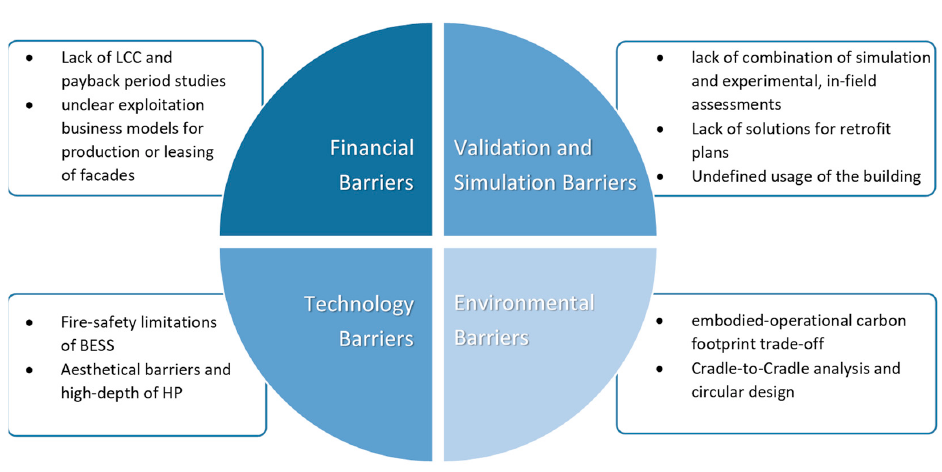
Figure 9. Barriers of ADBE successful implementation.